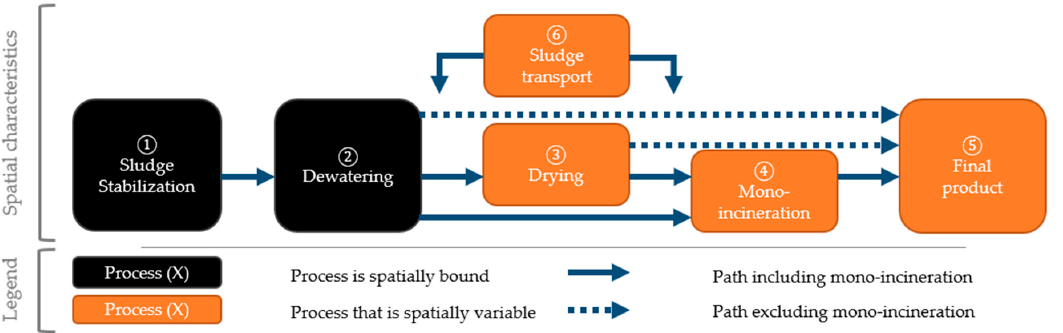
Figure 3. Spatially variable and bound processes considered for the scenario development.